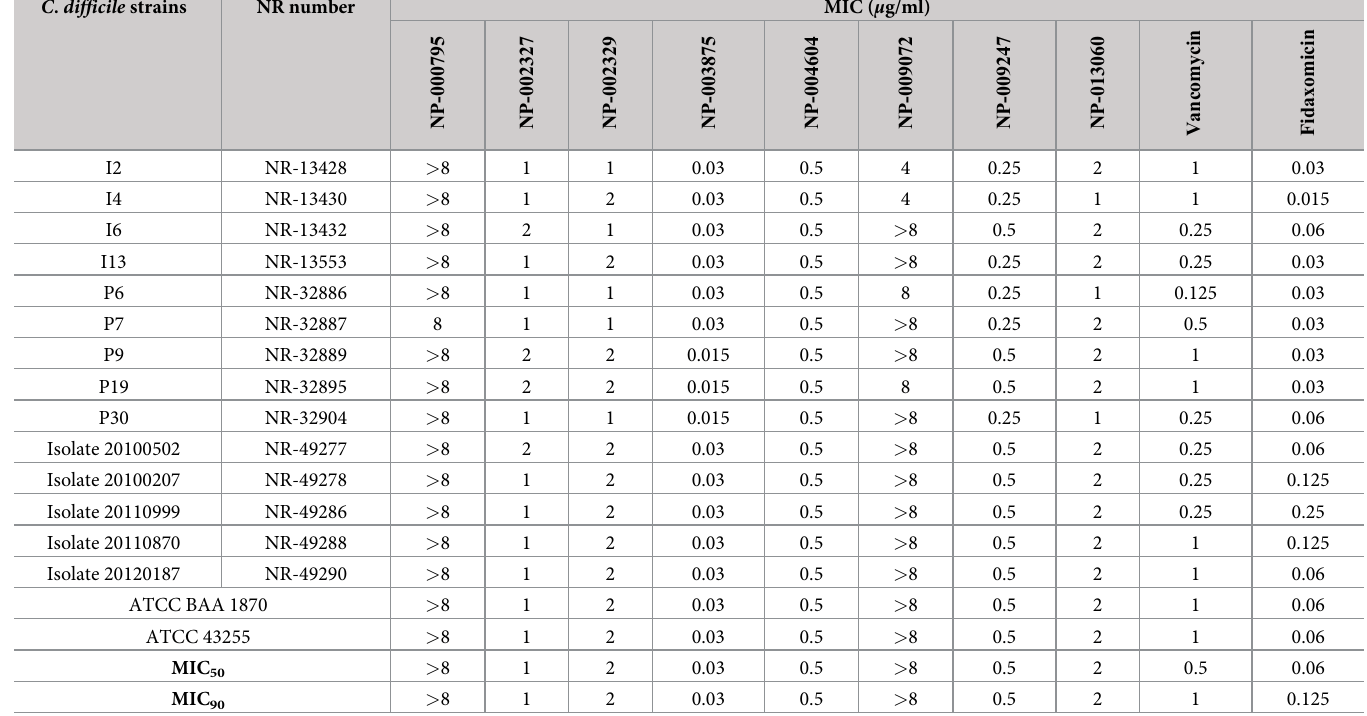
Table 1. Minimum Inhibitory Concentration (MIC) values of natural products against a panel of clinical and hypervirulent strains of C . difficile . C . difficile